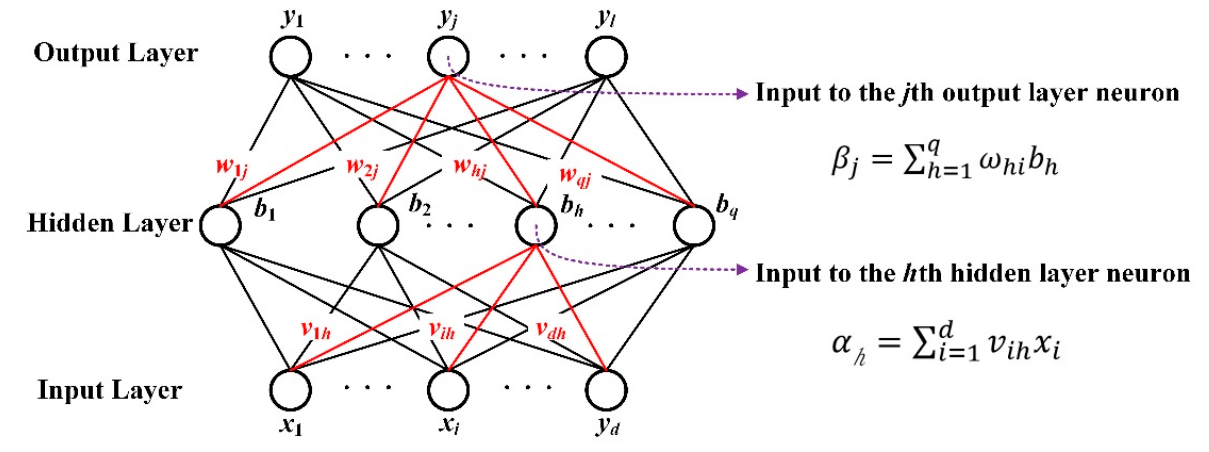
Figure 14. The model of BPNN.